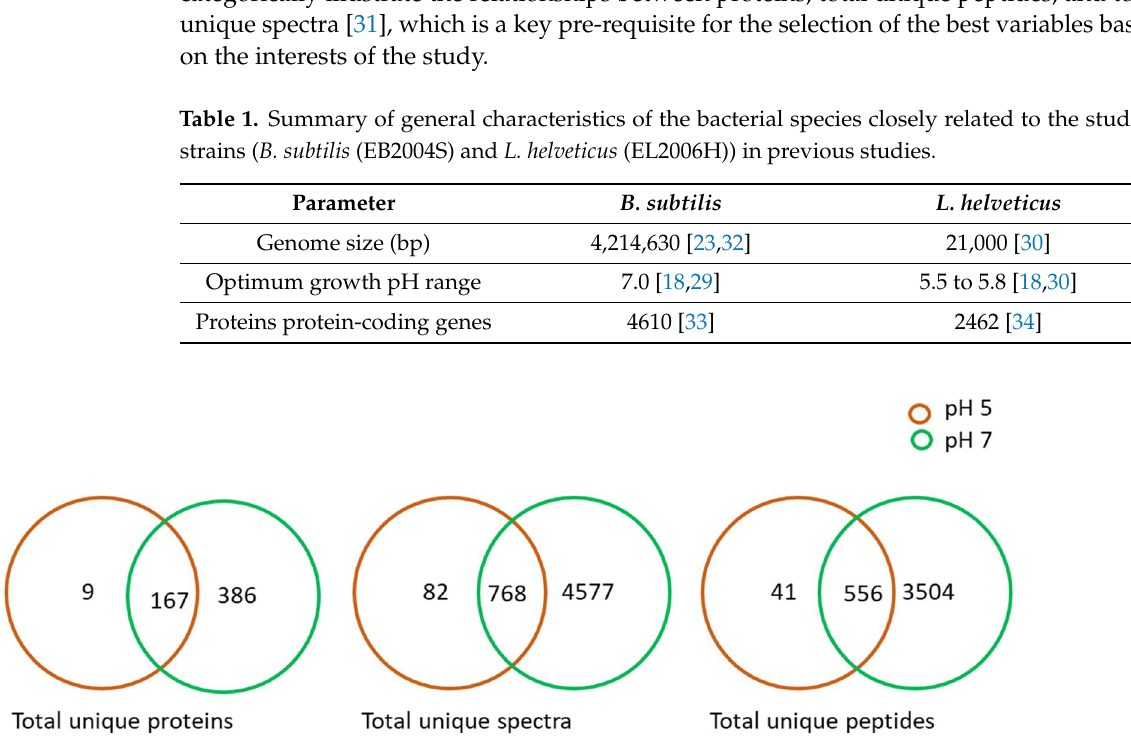
Figure 1. Venn diagram summarizing the total unique proteins, spectra and peptides obtained from L. helveticus (EL2006H) CFS at pH 5 and pH 7.